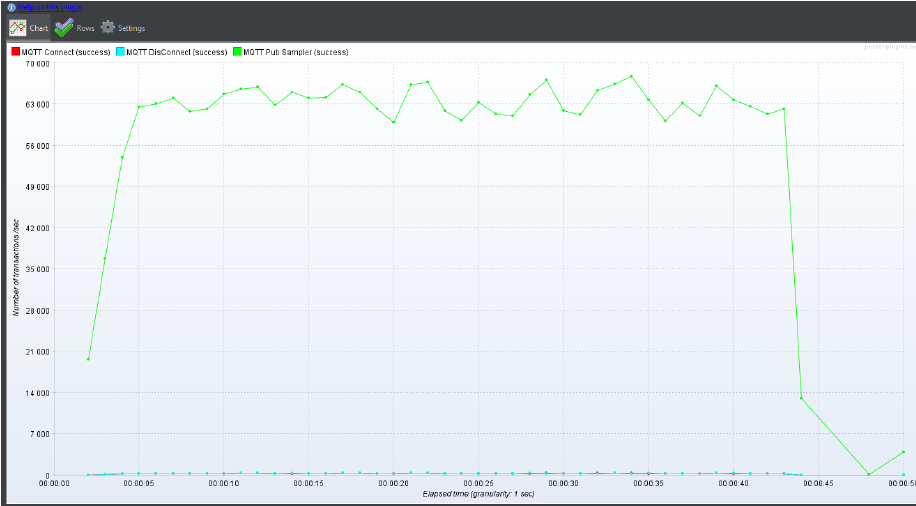
Figure 17. Screenshot of throughput evaluation using the Apache JMeter.